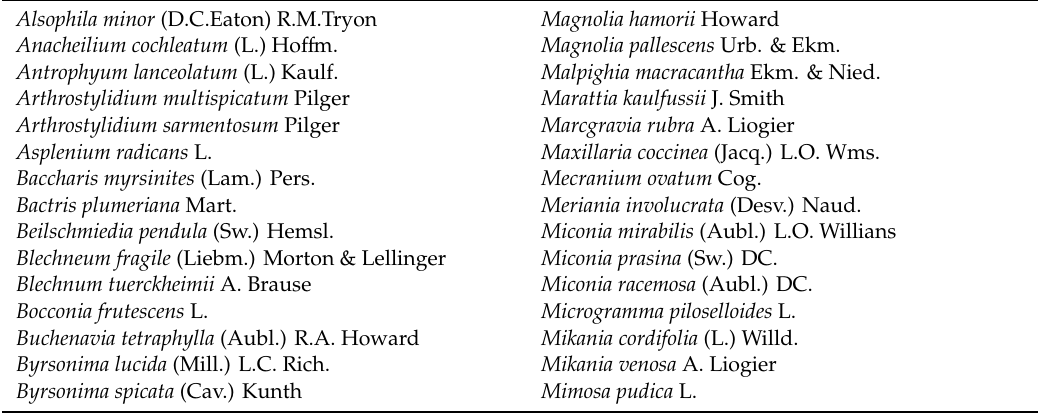
Table 2. Plant species found with our studies in the Dominican Republic (DR) and not present in the relev é s from Cuba